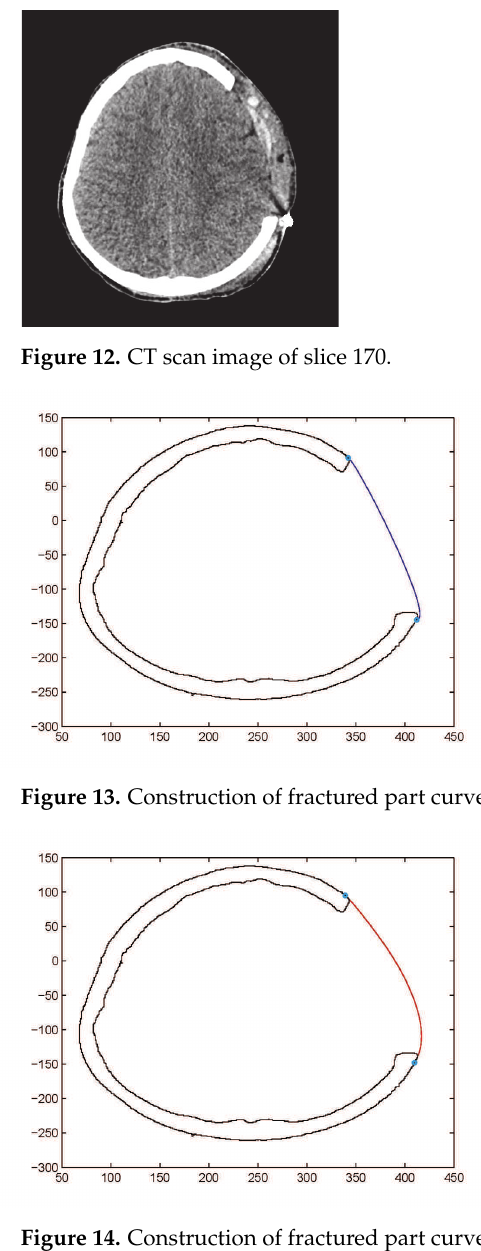
Figure 14. Construction of fractured part curve using GC 1 rational Ball